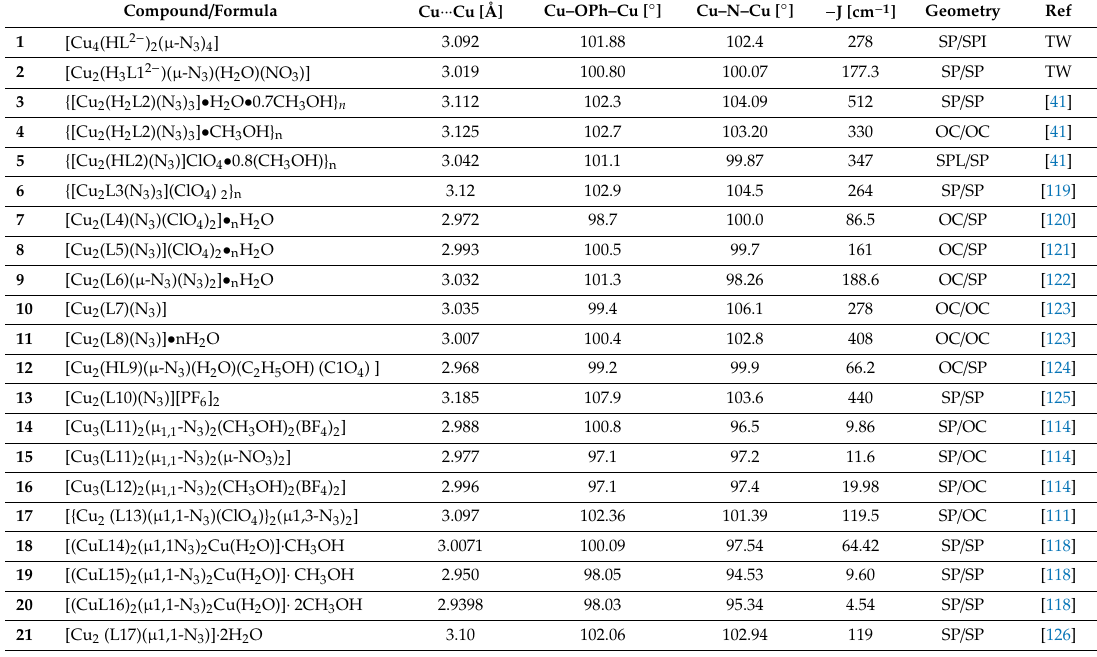
SP—Square pyramidal; OC—Octahedral; SPl—Square